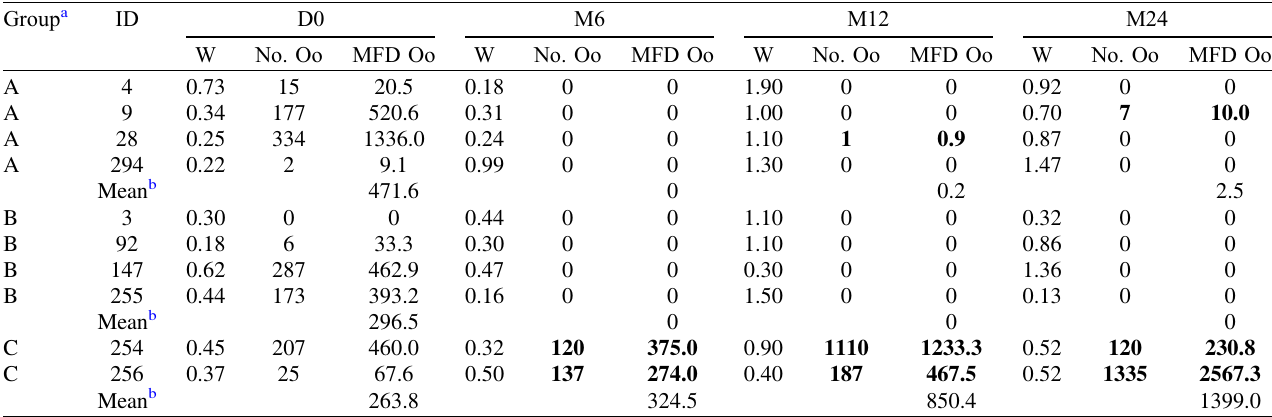
Table 2. Onchocerca ochengi MFD per gram of skin in each animal and each treatment group at D0, M6, M12, and M24. Post-treatment- positive results are shown in